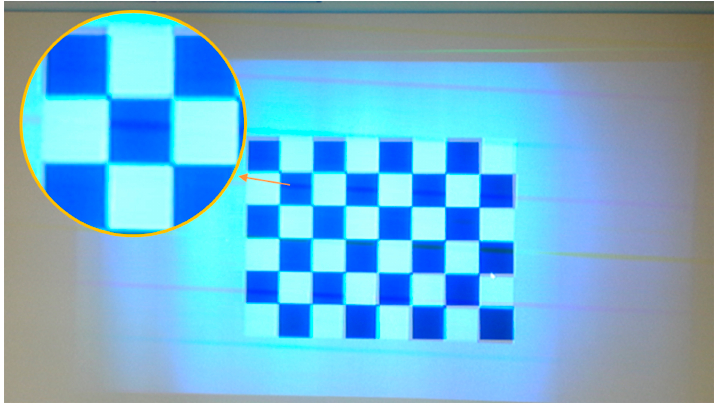
Figure 5. On-image displacements between direct view and VST view of a target scene. The test images were grabbed by an additional video camera placed approximately at the eye relief point of the eyepiece of the HMD.